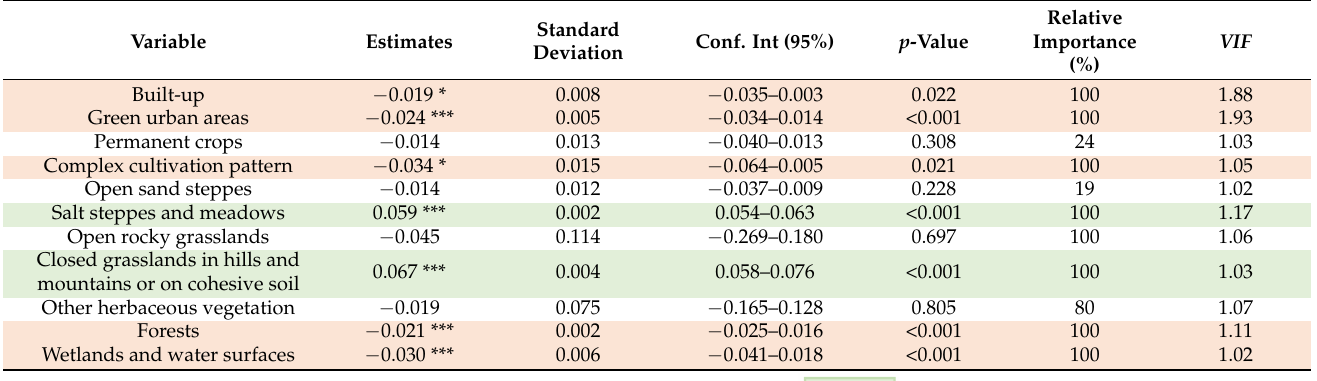
Table 2. Summary table for LULC categories, which shows the GLM results after multimodel averaging of best candidate models showing relative importance of each explanatory variable on Skylark abundance, estimated parameter values ± Standard deviation. (For detailed descriptions of the LULC categories see Table A1).